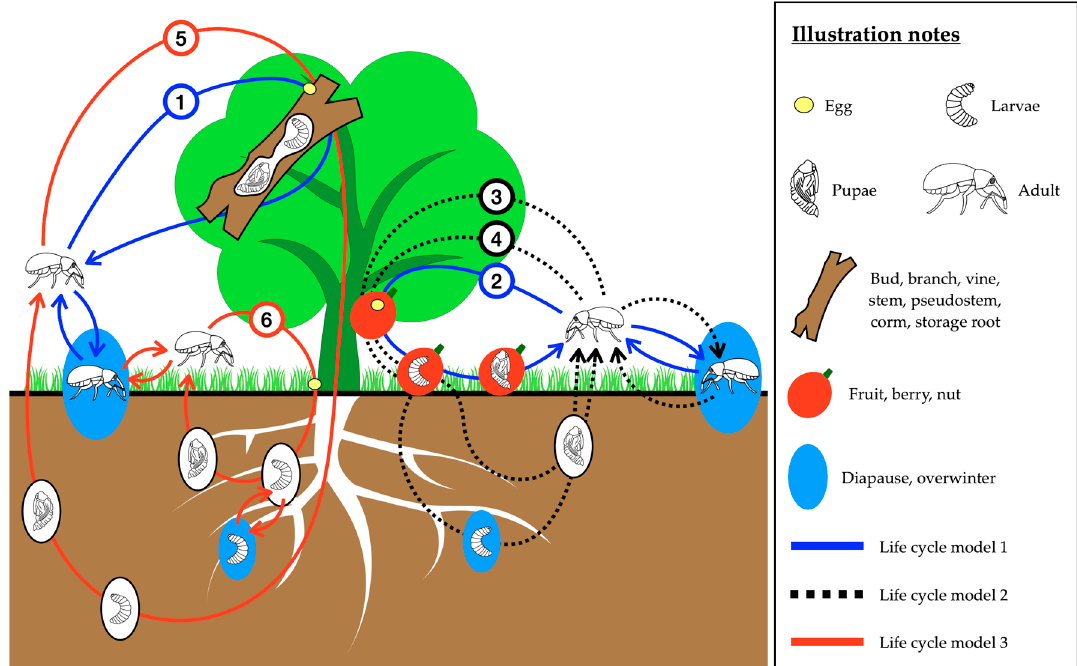
Figure 1. Overview of the life cycles of weevils attacking horticultural crops. The weevil species which were classified into subcategories 1–6 and life cycle models 1–3 in this figure are listed in Table 3.